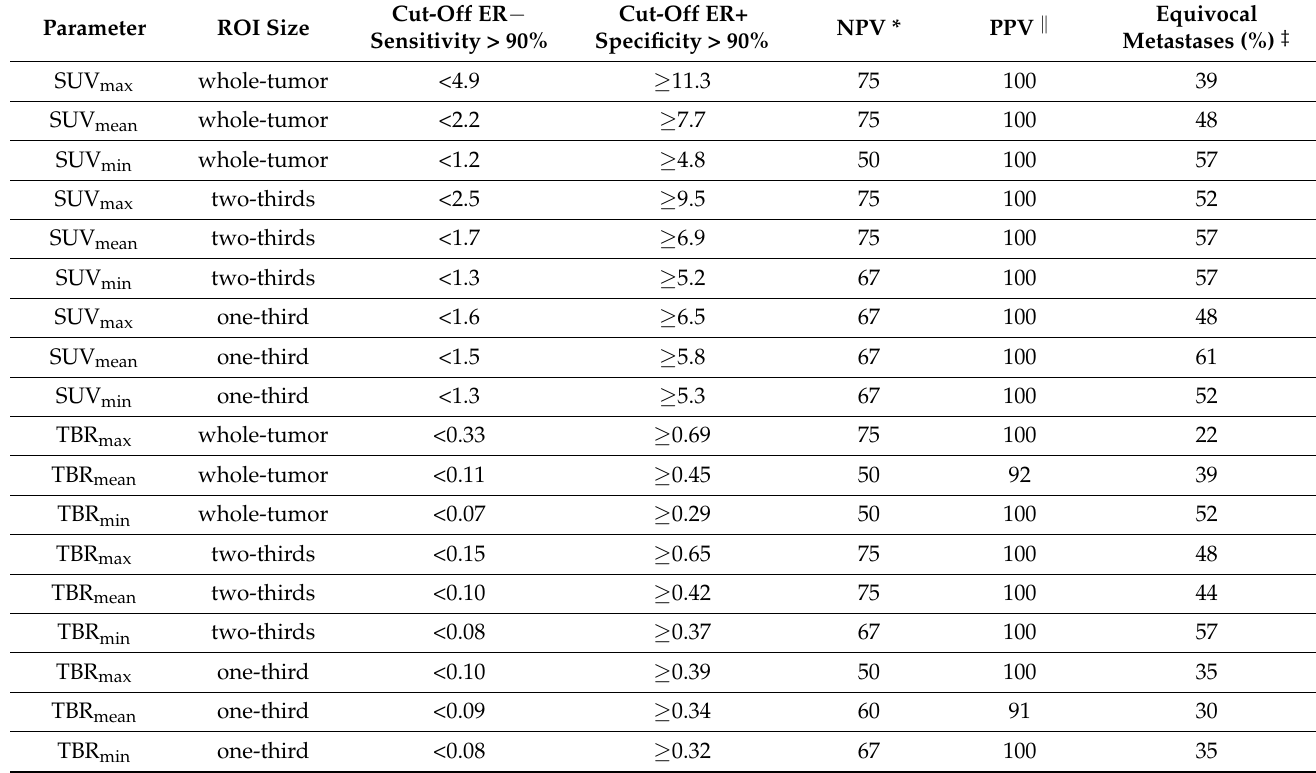
Table A3. PET parameters and cut-off values to determine ER status by [ 18 F]-FES-PET ( n = 23), using a cut-off value of ≥ 1% for ER